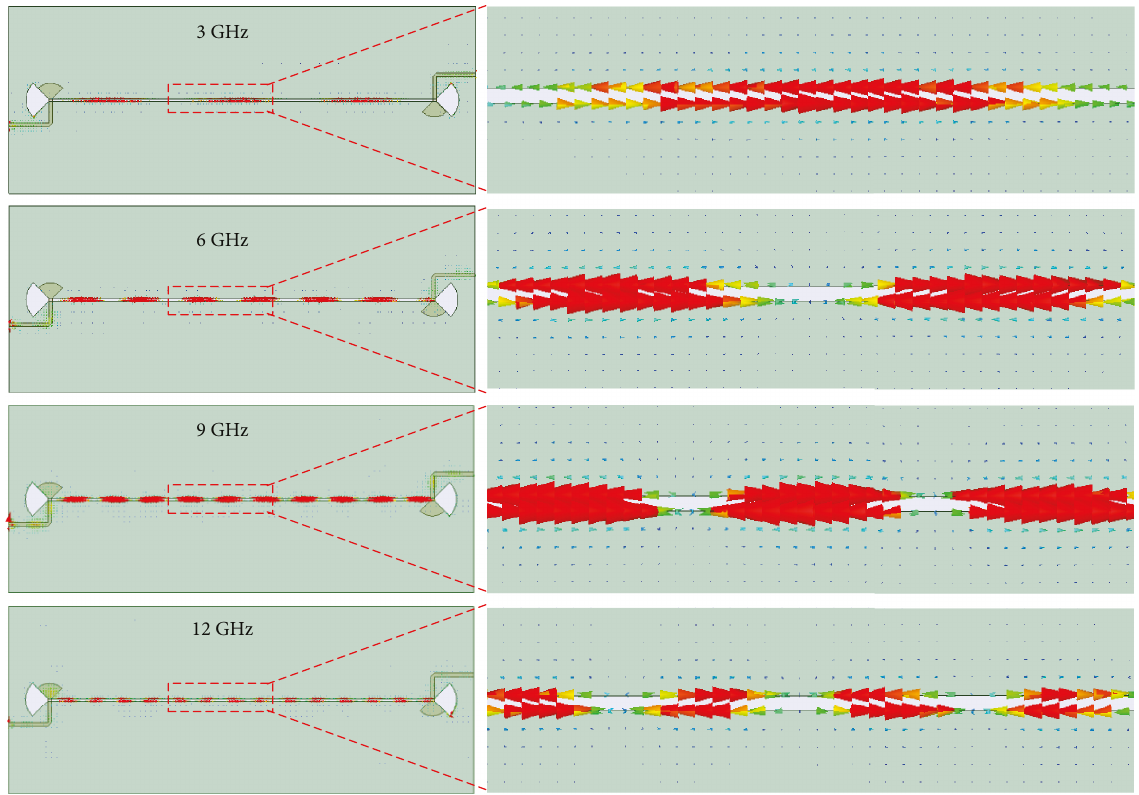
Figure 3: Surface current distributions at the several frequency points for the wideband microstrip-to-slotline transition.